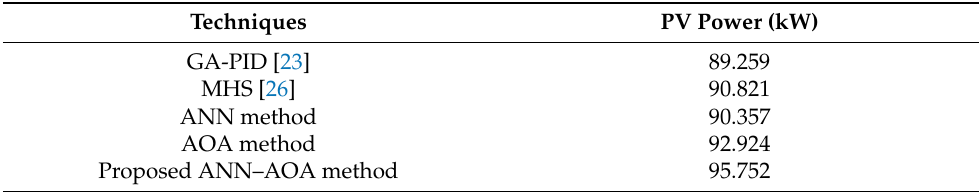
Table 2. Analysis of PV power under various methodologies.